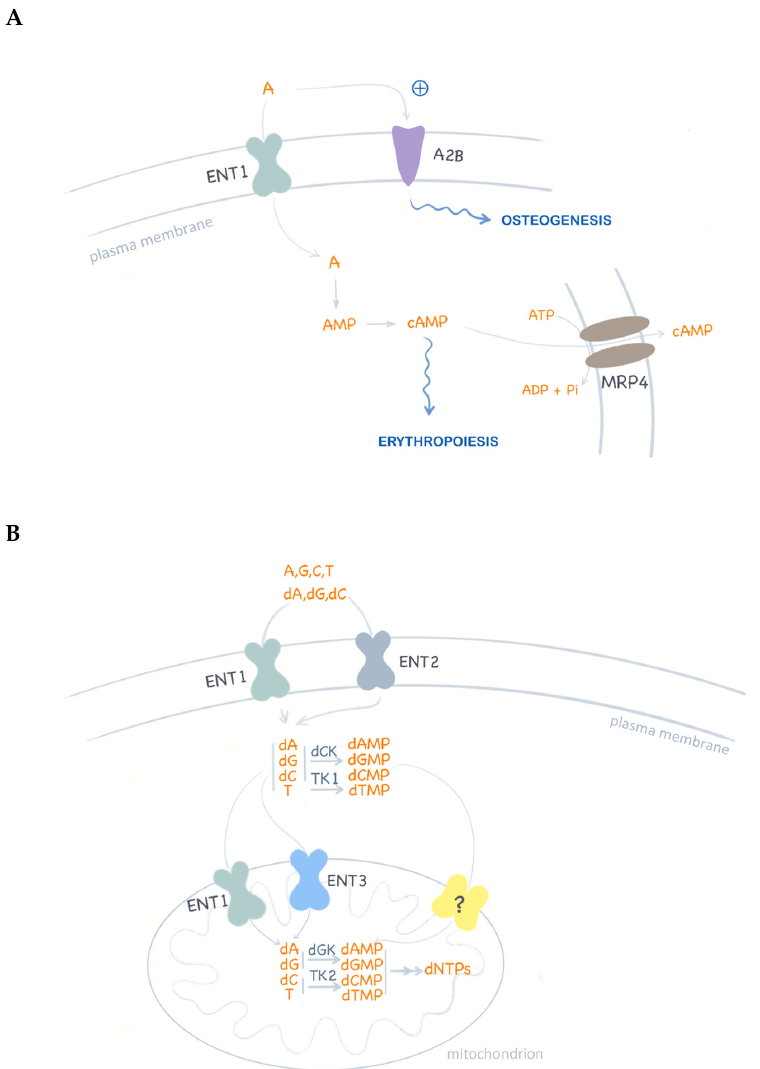
Figure 3. ENT1 functions in nucleotide metabolism. ( A ) Schematic representation of adenosine (A) translocation and signaling. Adenosine activation of P1 receptors (i.e., A2B) promotes osteogenic differentiation of mesenchymal stem cells. Intracellular cAMP levels are modulated by ENT1- associated adenosine translocation and also by MRP4 cAMP efflux. In turn, cAMP homeostasis is critical for erythropoiesis regulation. ( B ) Nucleoside uptake at the plasma membrane is mediated by ENT1 and ENT2 homo and hetero-oligomeric complexes. ENT1 has been reported to translocate nucleosides and deoxynucleosides in mitochondria. In ENT1 null cells, deoxynucleoside supply to mitochondria may be maintained by ENT3 function, although the proven functional expression of an unknown deoxynucleotide transporter (?) may be the best compensatory mechanism to maintain mitochondrial deoxynucleotide pools for DNA